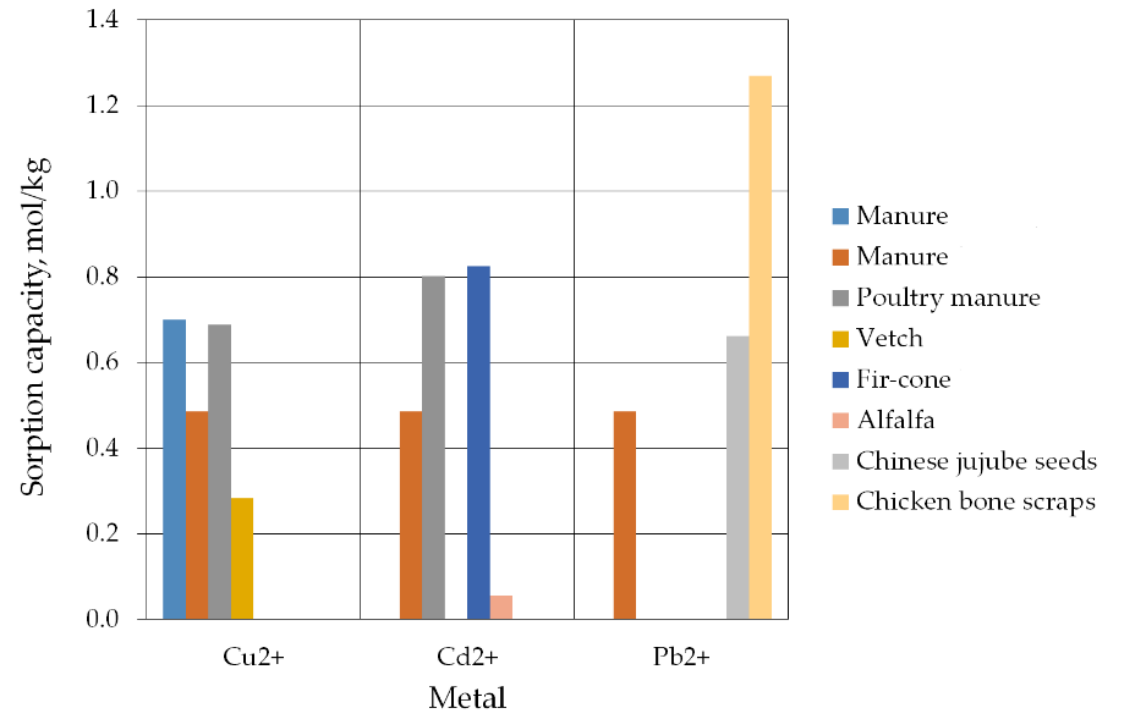
Figure 1. Sorption capacity of Cu, Cd and Pb for biochar made from organic materials. The aim of this work was to study the sorption properties of “Ecochar”, an organic material of biological origin, obtained from fresh chicken manure. The pre-dried poultry manure was heated in an oxygen-deficient environment to produce syngas and solid residue. These solids were coal, which still contained minerals from the incoming raw materials, and were called “Ecochar”. Syngas is composed primarily of CO, and this was oxidized and burned to produce a hot air stream. The technological scheme is shown in Figure 2.